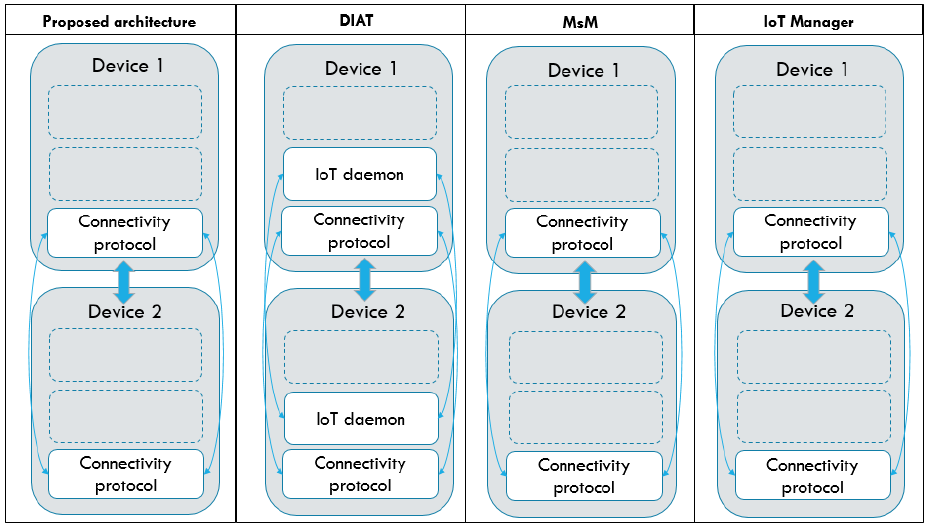
Figure 14. Minimum requirement for system interoperation for proposed architecture, DIAT and CEB Atlas.